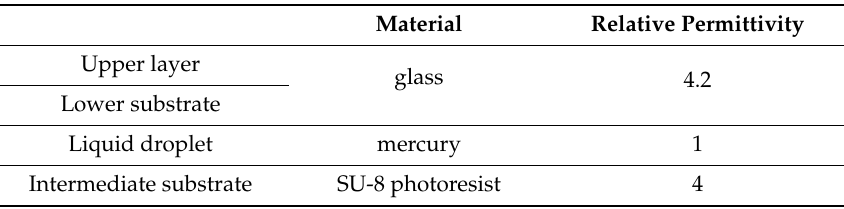
Table 1. The material properties of the model.